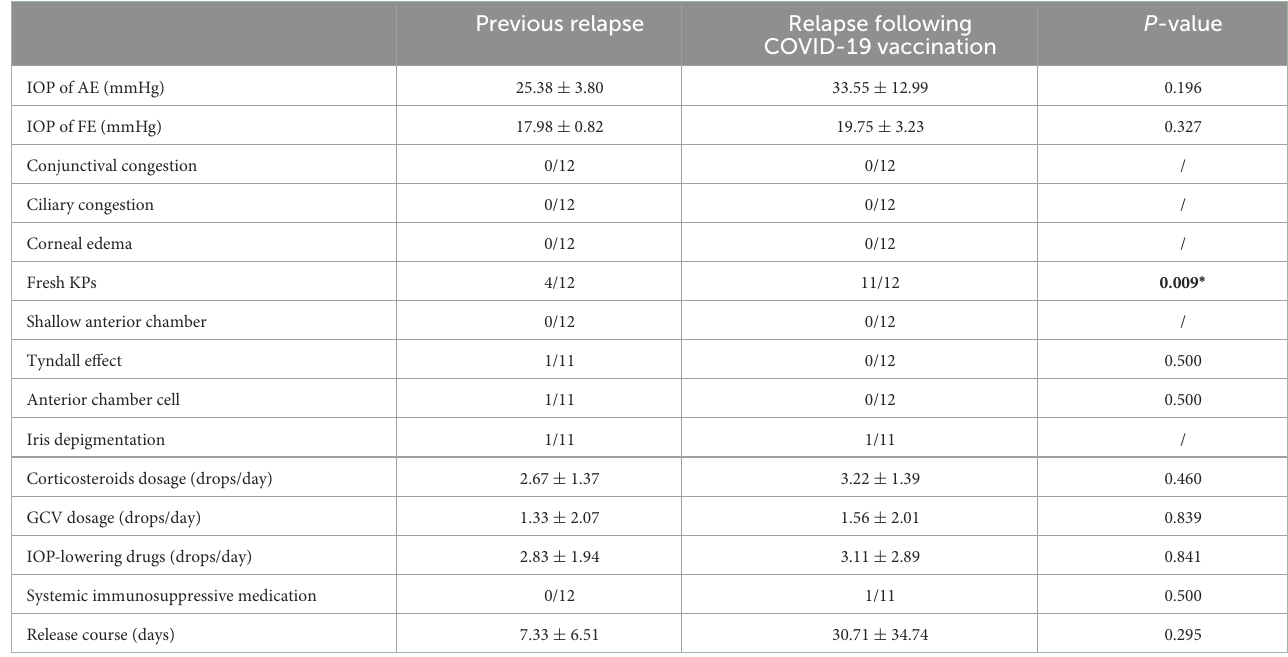
P Previous relapse Relapse following COVID-19 vaccination